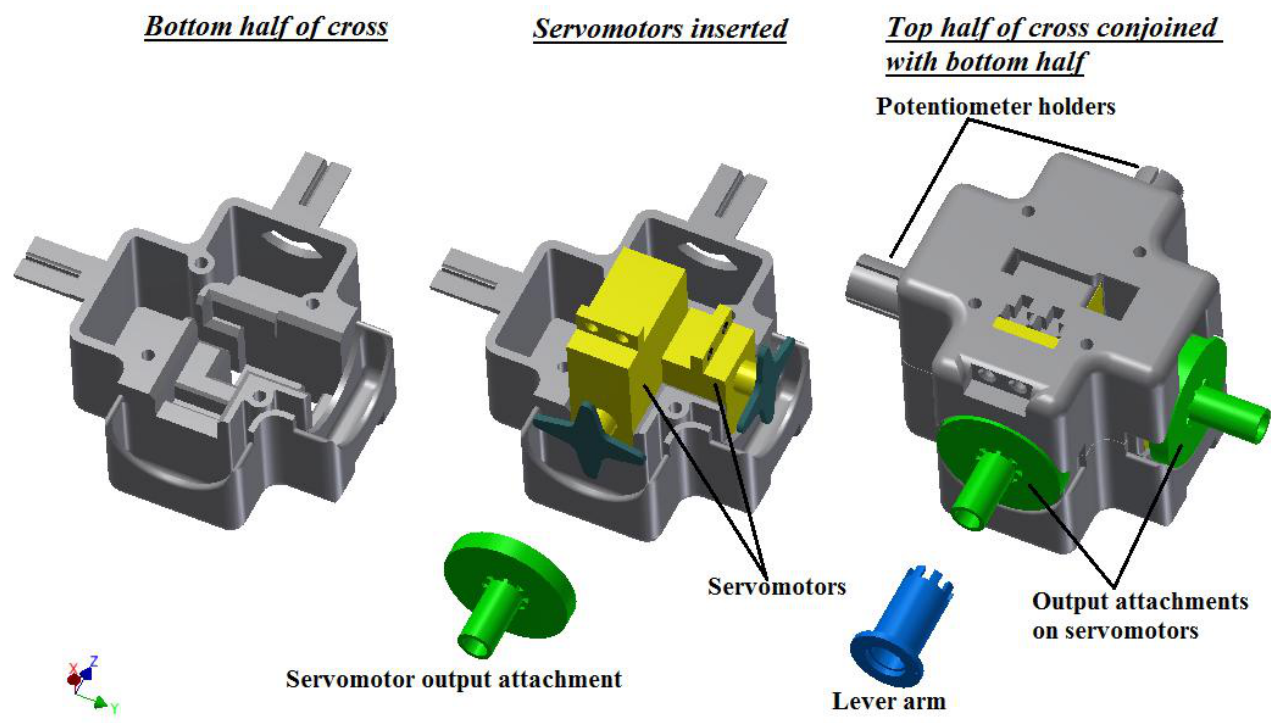
Figure 5. Assembly of the